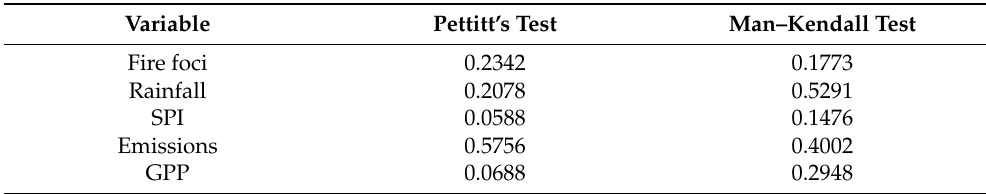
Table 1. Trend analysis ( p -value) applied to annual time series fire foci, rainfall, standardized pre- cipitation index (SPI), emissions, and gross primary production (GPP).